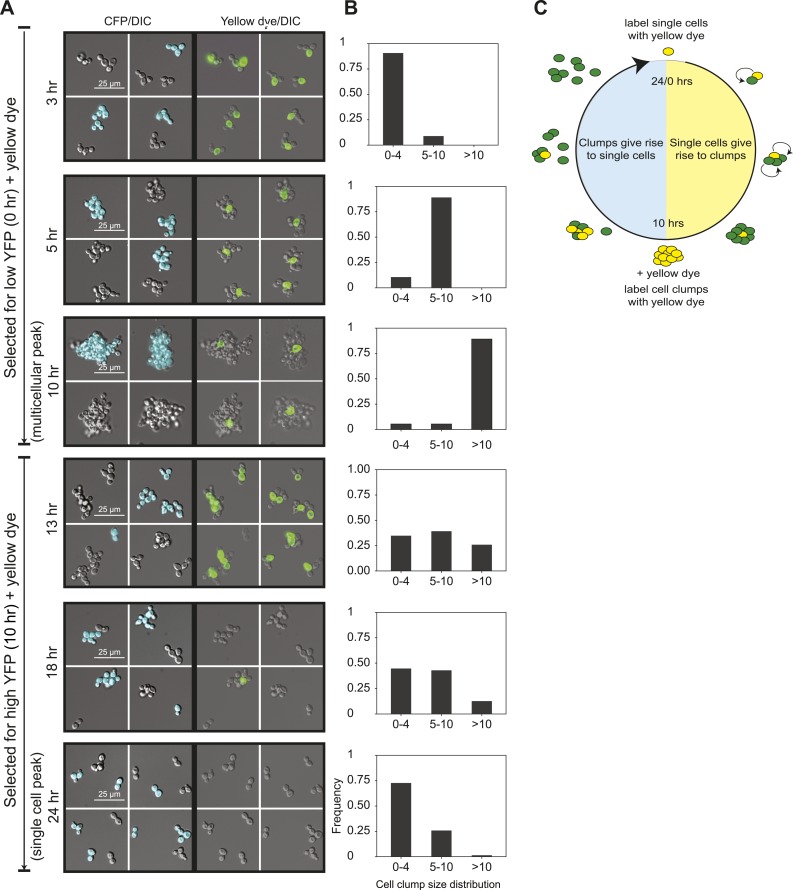
24-hour autonomous oscillations in dynamic aggregate assembly.(A) Representative images of a synchronized E6-1 population at different points through the 24-hr cycle. The experiment contained two genetically similar subclones, one expressing cerulean fluorescent protein (CFP+) and the other not (CFP−). After FACS selection (0 and 10 hr) cell walls were covalently labeled with Oregon Green 488-x N-hydroxy succinimidyl ester, making them fluoresce brightly. Yellow-labeled single cells give rise to the multicellular phase by sticking to their daughters and clumps of different lineages do not mix (i.e., there are no CFP clumps with both CFP+ and CFP− cells). Labeled clumps give rise to single cells and smaller clumps by clump fragmentation and producing single-celled daughters. Time scale is in reference to the initial collection of single cells (Low YFP selection, T = 0 hr) over a 24-hr period. (B) The population from the experiment described in (A) was quantified by calculating the frequency of clumps containing 1–4, 5–10, and >10 cells. There is a synchronous rise in clump size during the transition from single cells to clumps and a gradual decay of clump sizes during the transition from clumps to single cells. (C) Schematic representation of oscillator dynamics: single cells give rise to the multicellular phase by sticking to their progeny to form a lineage-based clump. At the peak multicellular phase, clumps give rise to the single cell phase by fragmentation and producing single-celled daughters some of which adhere to their progeny to produce small clumps.